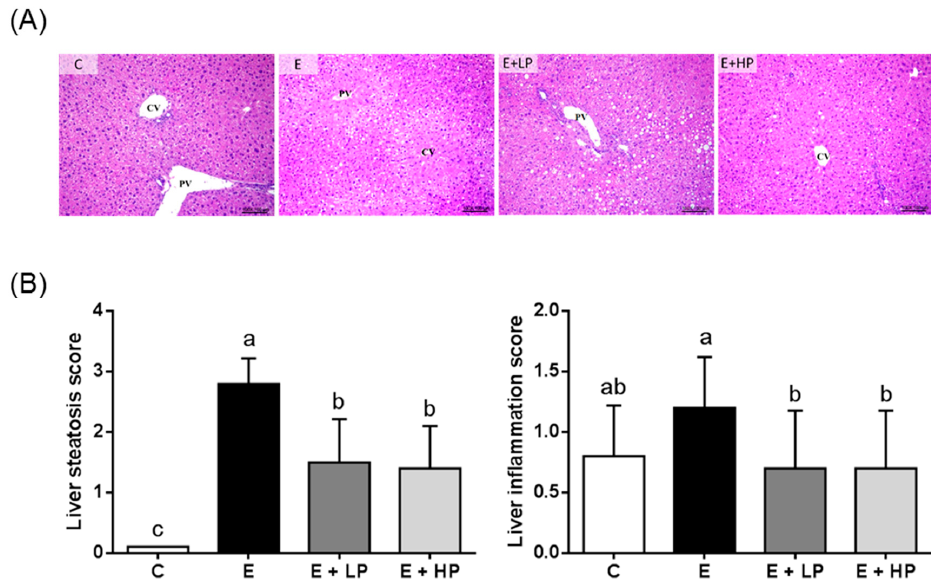
Figure 1. Histopathological changes in the liver of mice at the end of the study. ( A ) Photomicrographs of hematoxylin and eosin (H&E)-stained mouse liver sections (original magnification, 100×). ( B ) Pathological scores. Values are expressed as the mean ± SD ( n = 10). Significant differences ( p < 0.05) are identified by different letters (a,b). C, control group; E, ethanol group; E + LP, low-dose PPE group; E + HP, high-dose PPE group; CV, central vein; PV, portal vein.